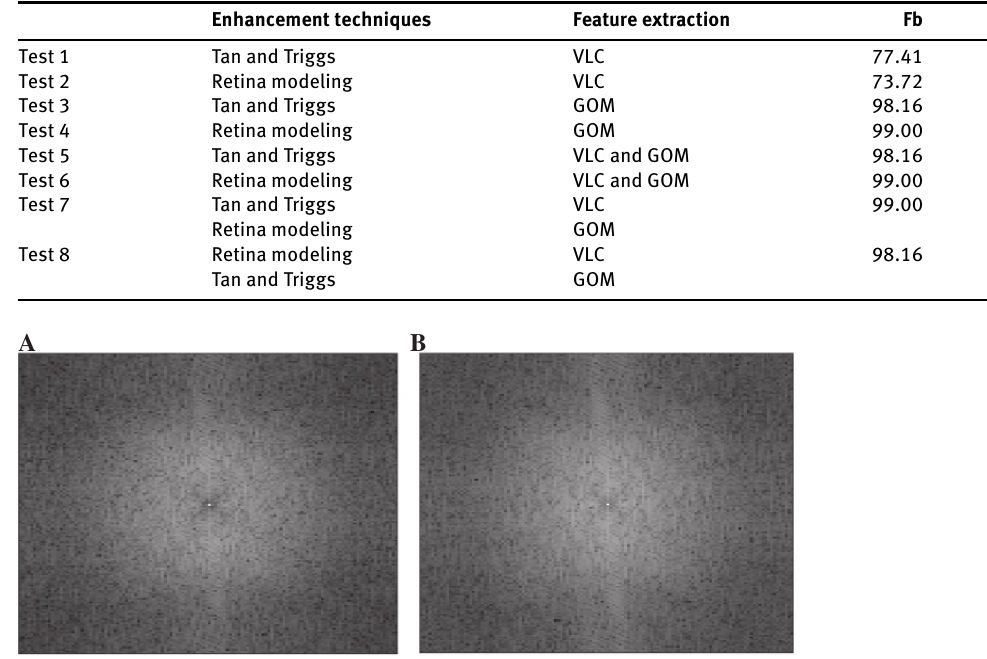
Table 2: FERET Data Sets Result.